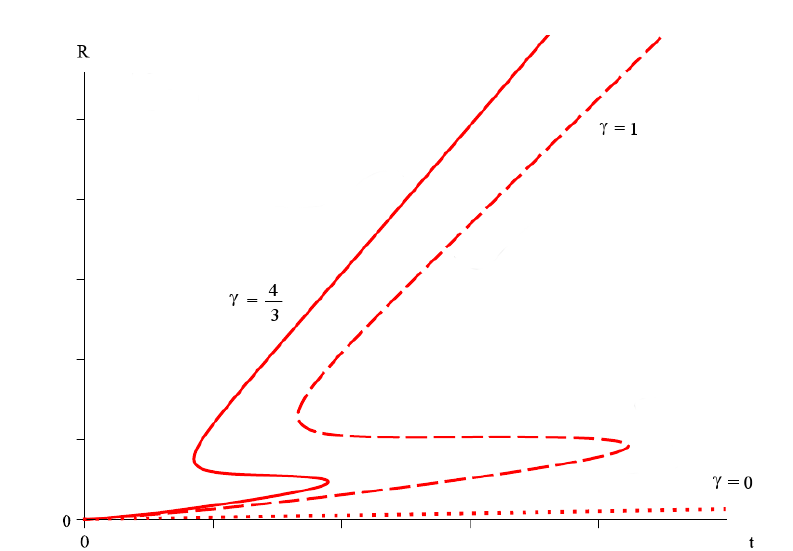
Figure 6. The radii of the apparent horizons for Brans-Dicke coupling ω = 1. At early times there is a single horizon for all three values of γ . As time goes by, two more apparent horizons appear. Two of these horizons eventually merge and disappear, leaving a naked singularity in a FLRW universe, which has its own cosmological horizon. Figure 7 zooms in on the third curve, which here appears flattened along the time axis.